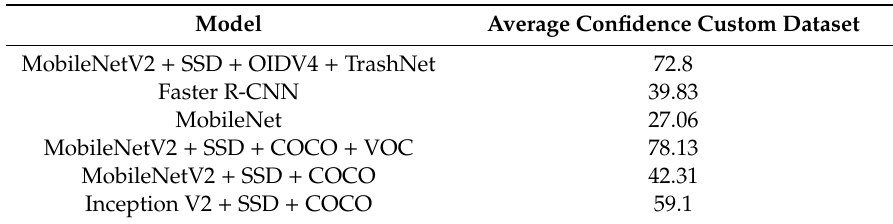
Table 6. Evaluation on our waste test dataset at inference time.